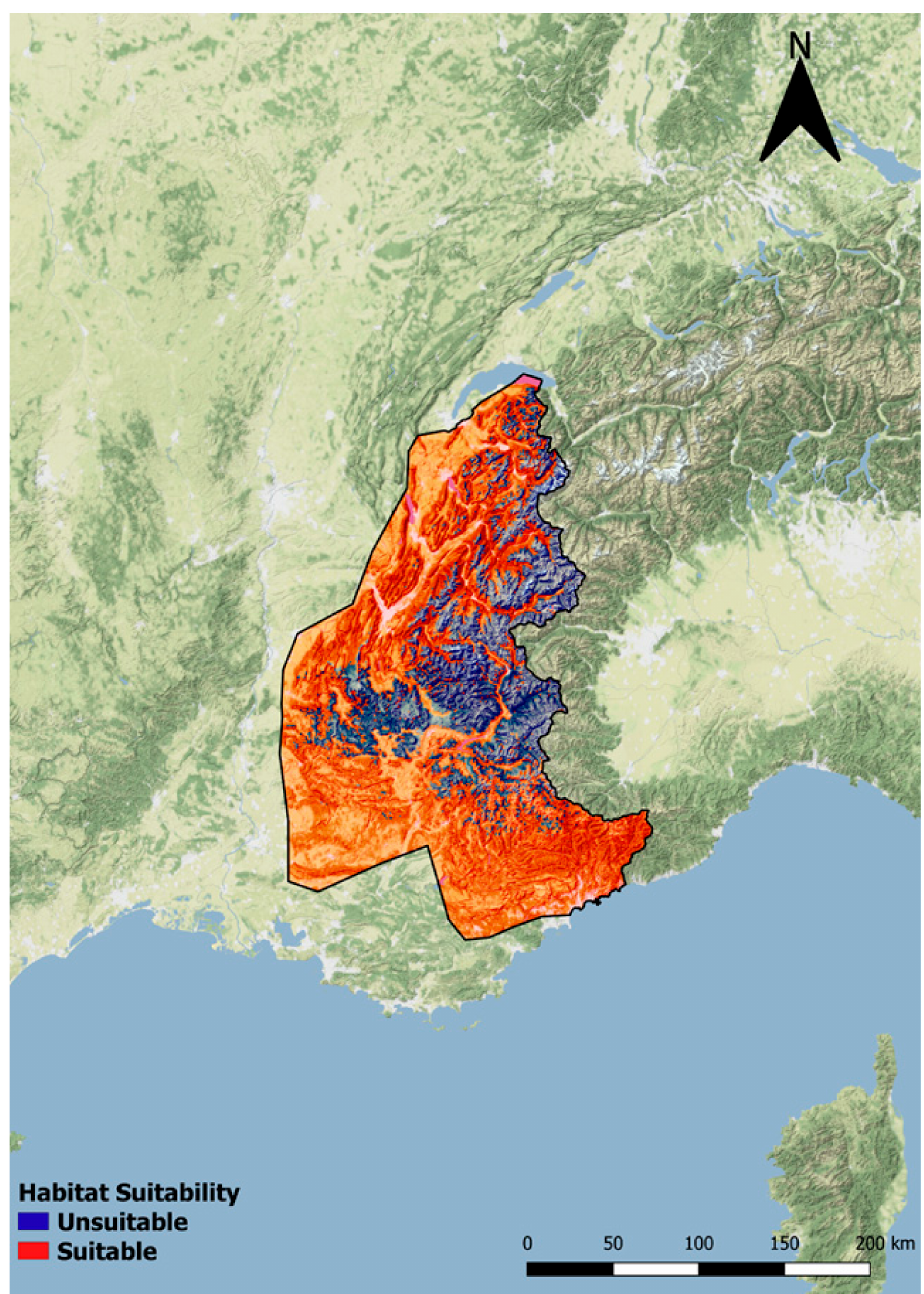
Figure 5. C. hamulosa habitat suitability in the French